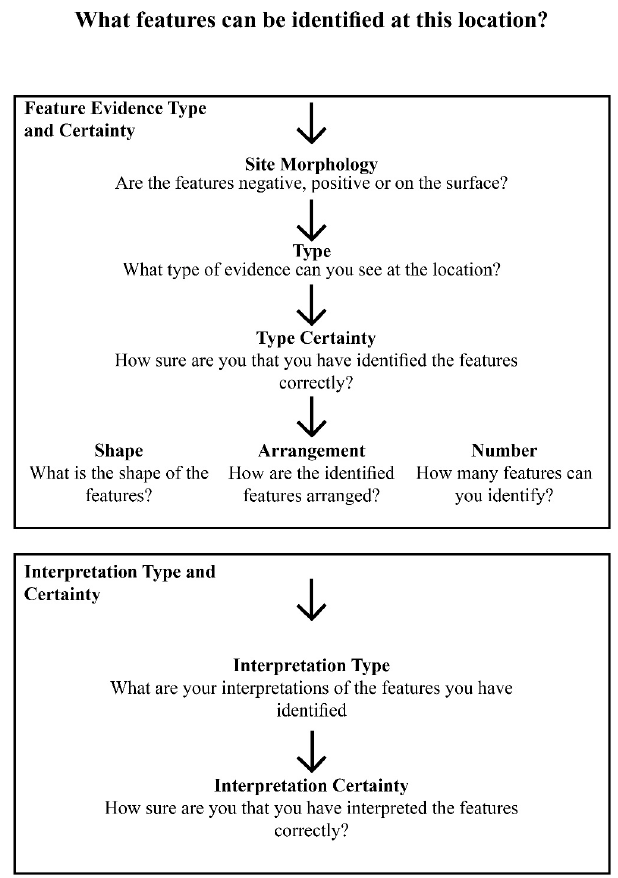
Figure 2. Flow chart of decision making process-draft described above.